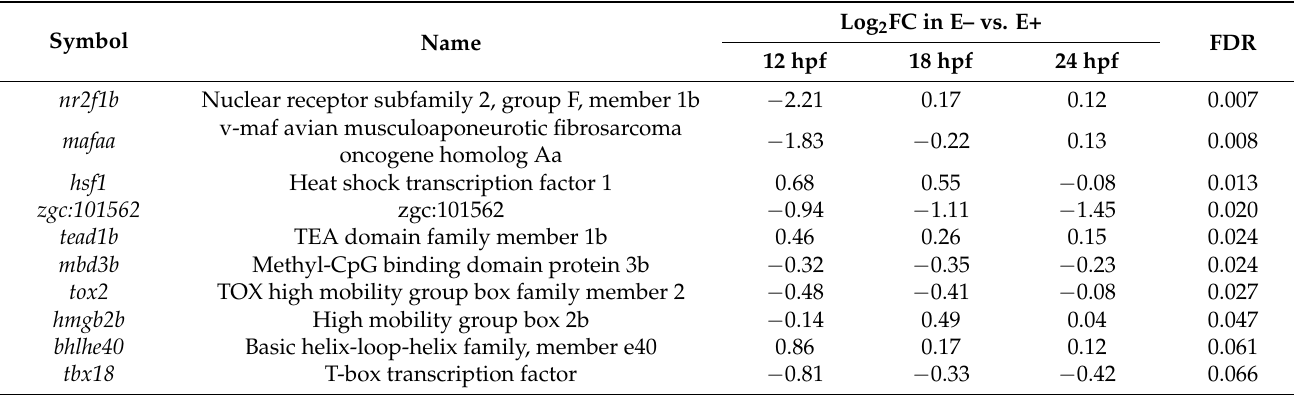
Table 2. Top transcription factors differentially expressed in E– embryos across the developmental window measured. Transcription factors (TFs) identified within DEG list annotated for TF family, anatomical region of expression at the measured time point and log 2 FC in E– embryos relative to E+.